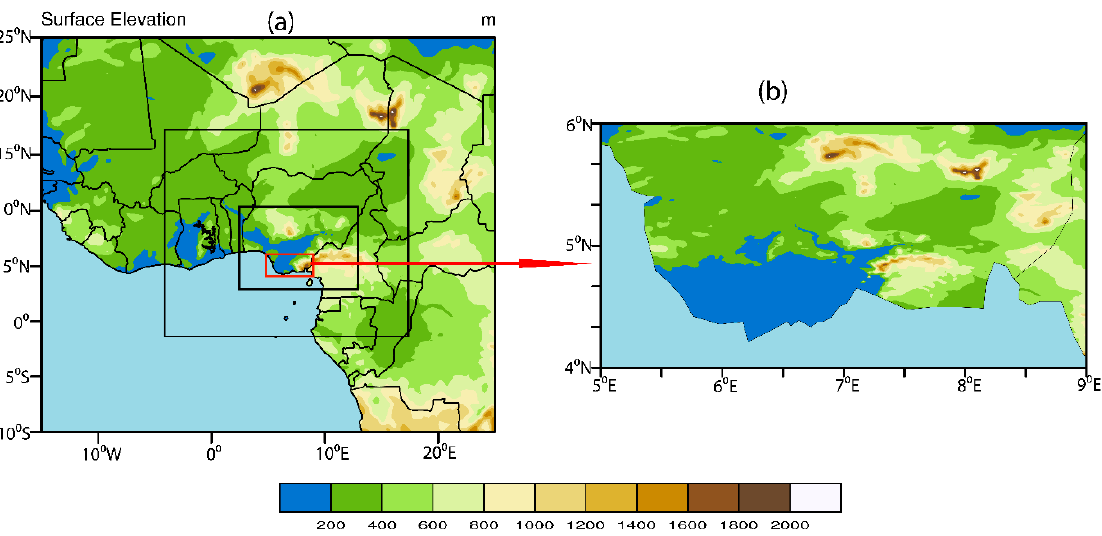
Figure 1. ( a ) Topographical map showing the simulation nested domains ( b ) The enlarged. inner red rectangle (5° E–9° E, 4° N–6° N) shows the area analyzed in this study.